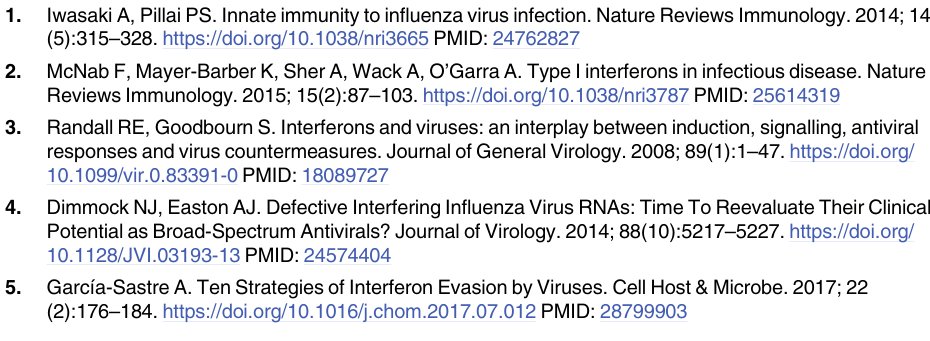
sorted on IFNL1 reporter expression. As expected, both infection and interferon expression was enriched during our sort. Each point indicates a technical replicate measurement of tran- script values for each individual experimental technical replicate and biological replicate. (TIF) S22 Fig. Deletion abundance in RNAseq data presented in Fig 5D and 5E. Using the pipe- line described in methods, both total fragments, and unique fragments, mapped to deletions in each segment across all six replicate